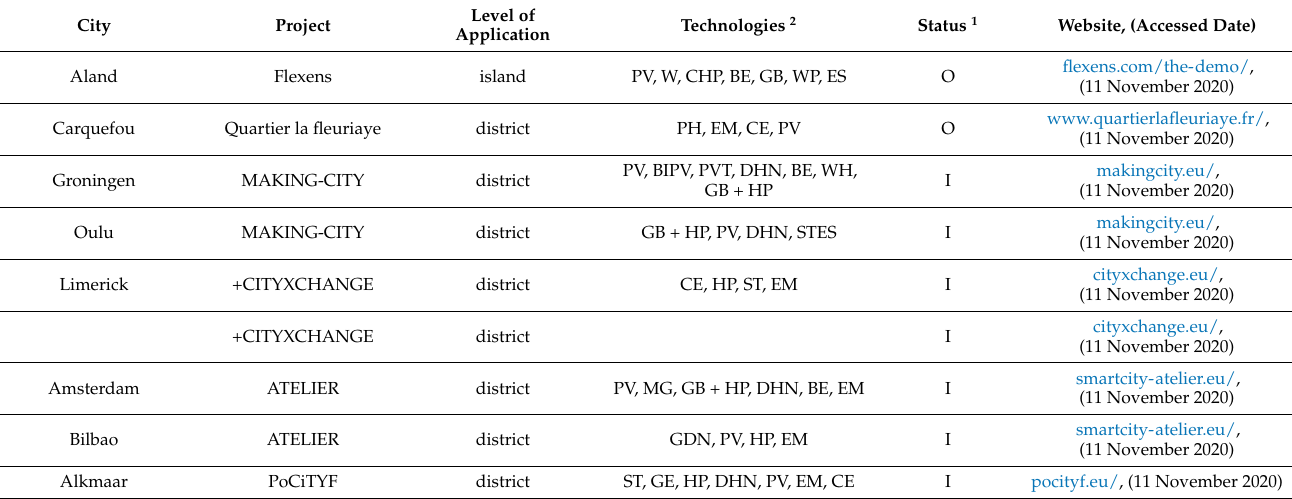
Table 1. Positive and Zero Energy Concept application across the world including ZEBs and